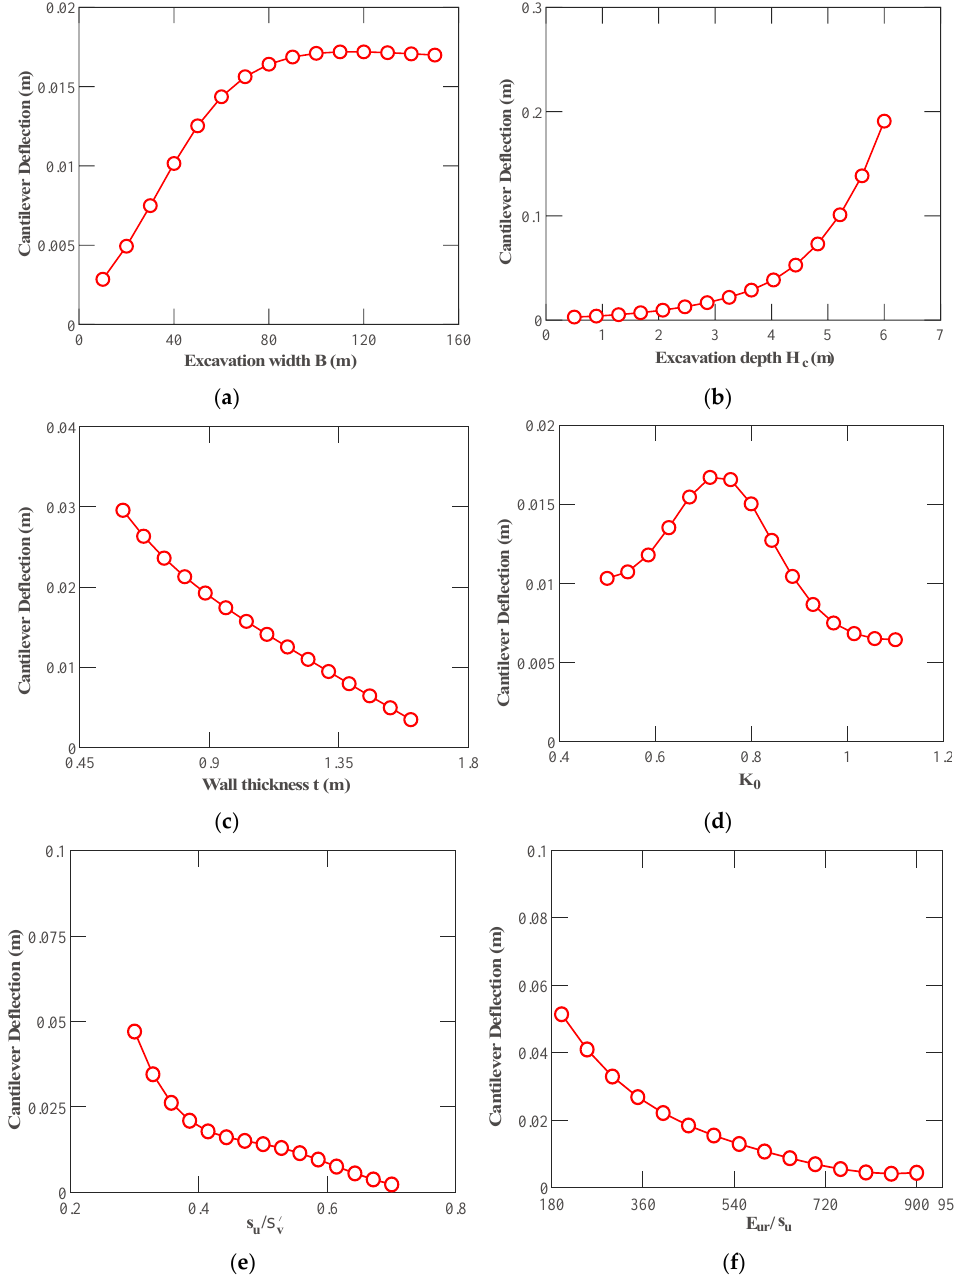
Figure 15. Influence of input parameters on the cantilever wall deflection. ( a ) influence of the excavation width B ; ( b ) influence of the excavation depth H c ; ( c ) influence of the wall thickness t ; ( d ) influence of the at-rest lateral earth pressure coefficient K 0 ; ( e ) influence of the soil shear strength ratio at mid-depth of the wall s u / σ v ′ ; ( f ) and influence of the soil stiffness ratio at mid-depth of the wall E ur /s u .